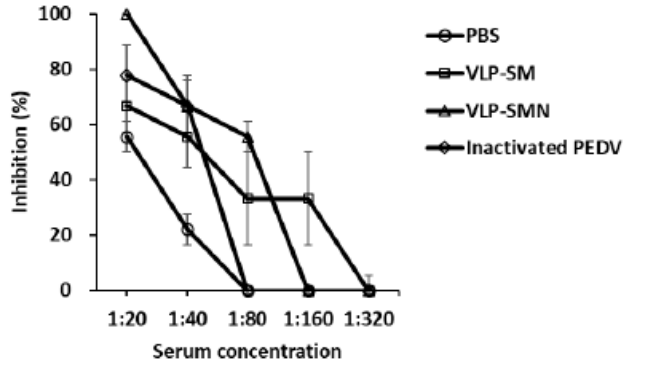
Figure 4. Protective efficacy of PED VLP immunization. Detection of neutralizing antibody titers in the serum of the immunized mice using the serum neutralization (SN) test. Results are expressed as the mean ( n = 4) of SN titers ± SD values and are representative of at least two independent experiments.